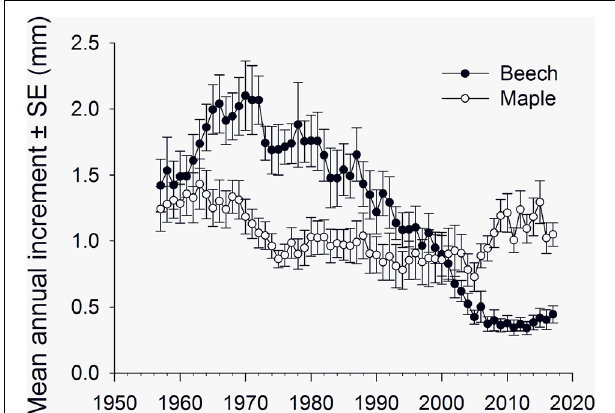
FIGURE 4 | Mean annual increment ( ± SE, n = 12 trees per species) of American beech and sugar maple, 1952–2017, Sandy Lake, Nova Scotia, showing a general decline in growth rate of American beech from 1970 to 2010 and an increase in growth rates of sugar maple relative to American beech, around 2003–2004.